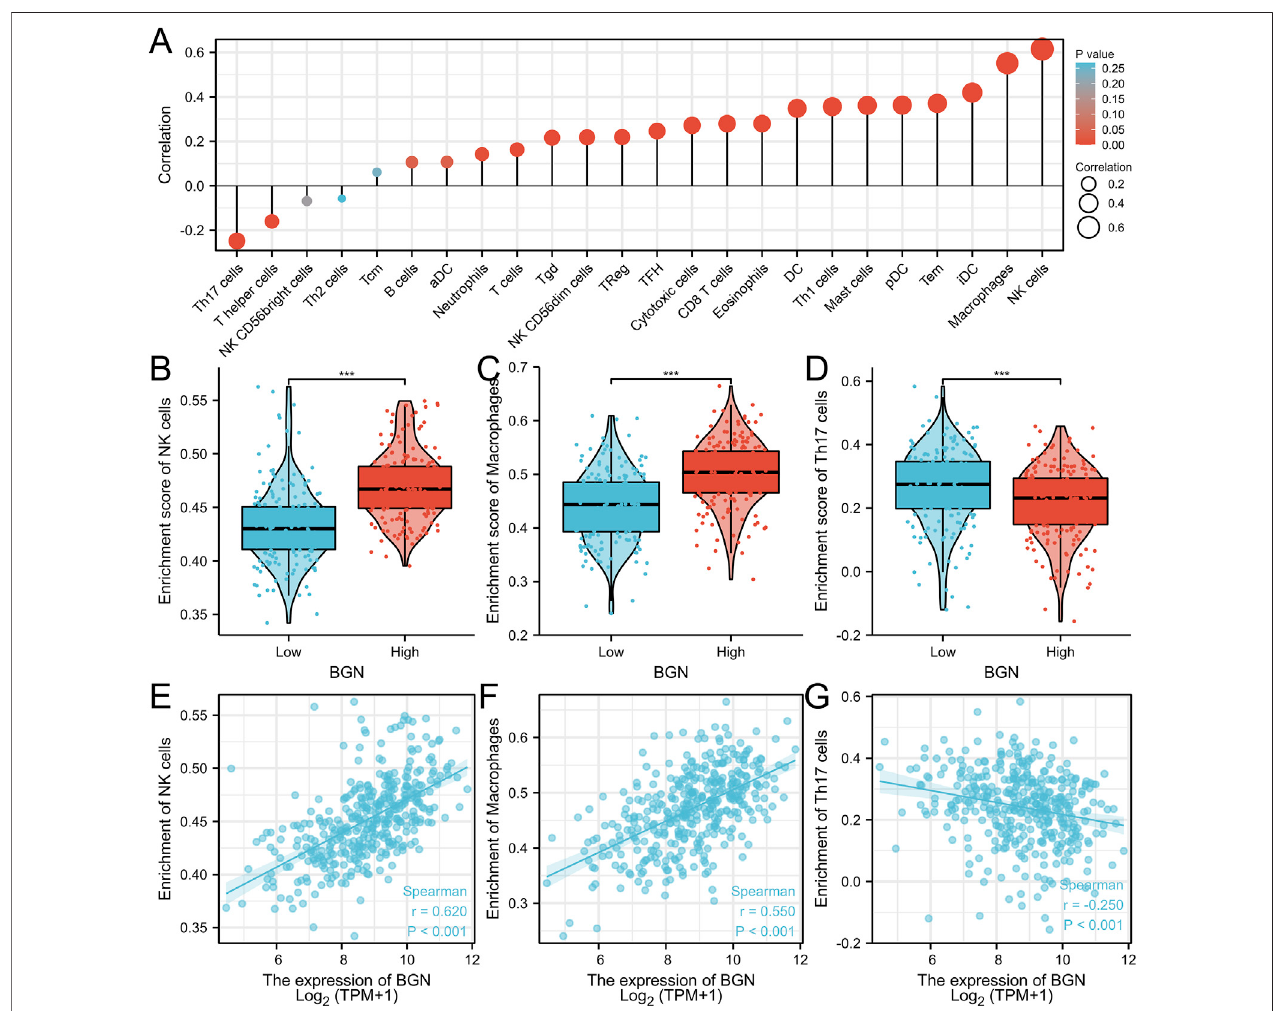
FIGURE 2 | The results of Real-Time PCR and Immunohistochemistry. (A) BGN expression in normal tissue (200X). (B) BGN expression in gastric cancer tissue (400X). (C) BGN expression in normal tissue (200X). (D) BGN expression in gastric cancer tissue (400X). (E) Relative BGN mRNA level in normal and GC tissues. GC: Gastric cancer. **, p <